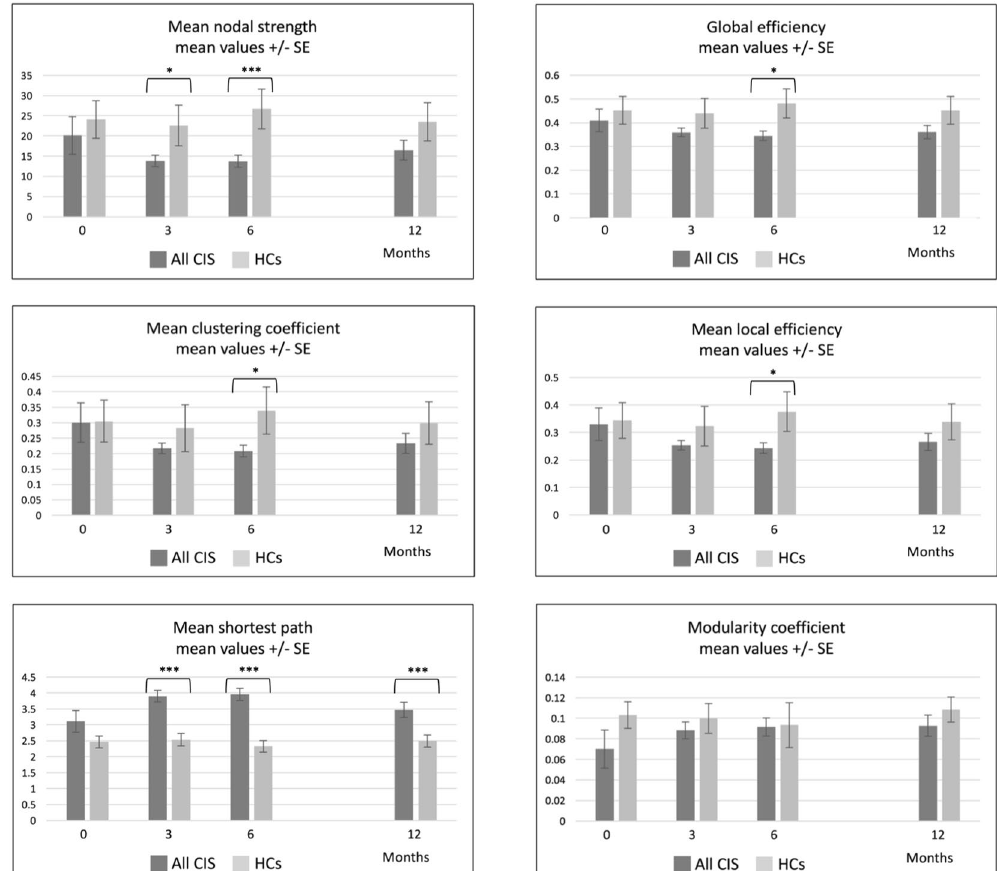
Figure 1. Network metrics over time in all CIS patients and HCs. This figure shows the evolution of network metrics over time for patients’ and controls’ networks, with the bootstrap standard errors. Although at follow-up only the mean shortest path was significantly different between patients’ and controls’ networks, at six-month follow-up, most of the metrics were significantly different between the two networks; * p < 0.05; ** p < 0.01; *** p <